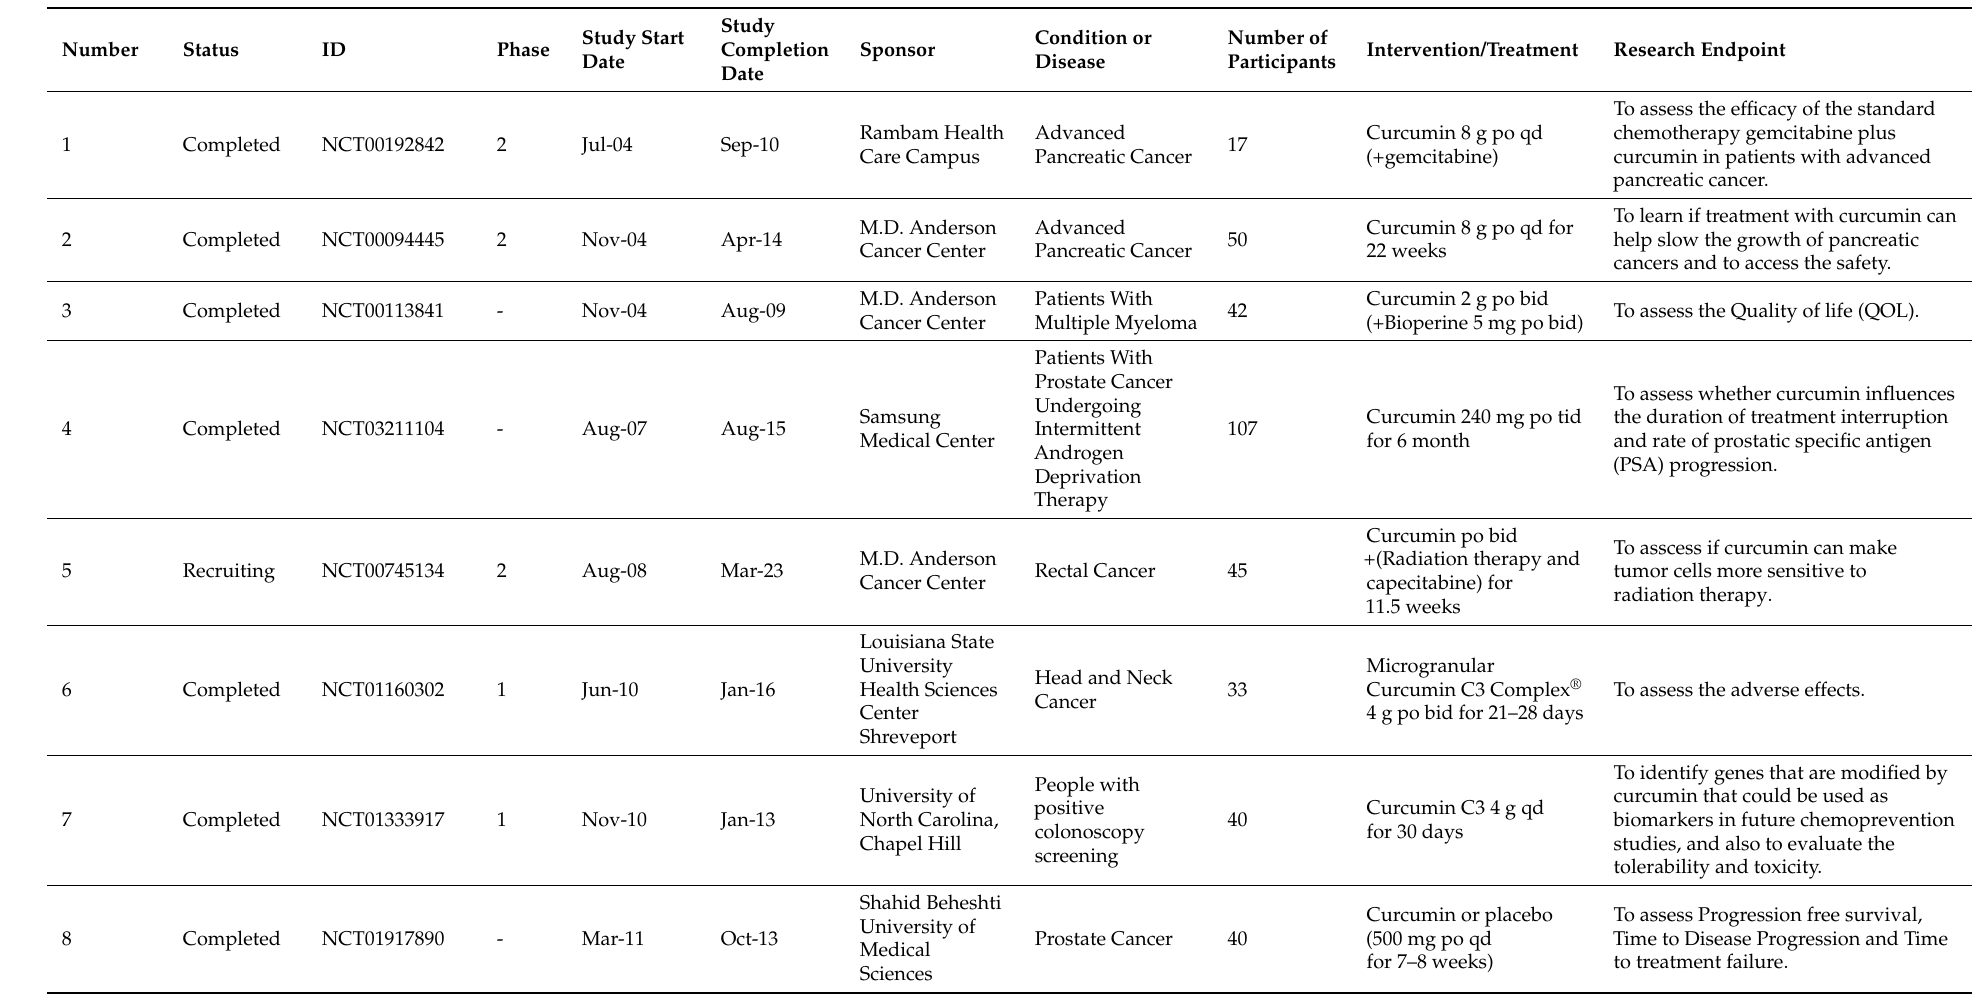
Table 1. Details of curcumin clinical